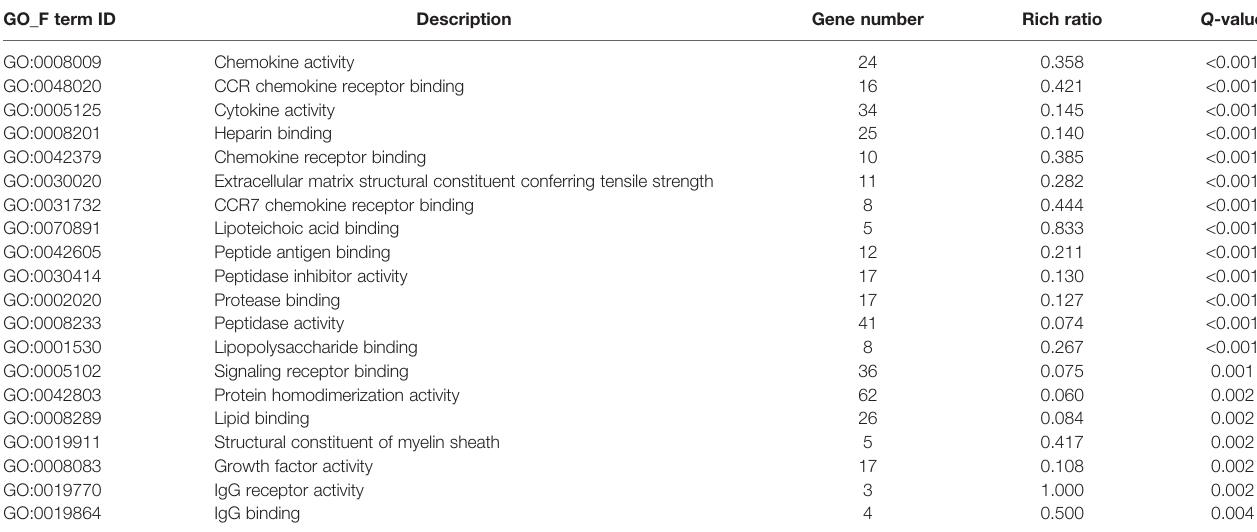
TABLE 3 | Signi fi cantly enriched processes of DEGs using the GO-MF database.